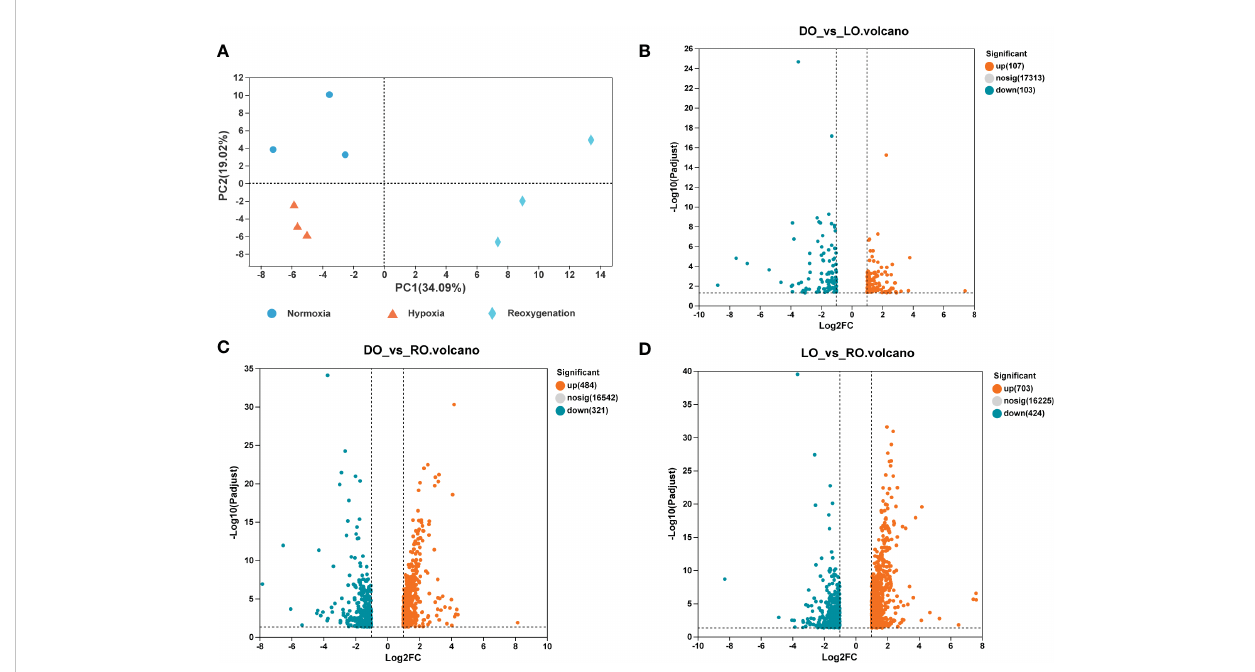
FIGURE 4 Clustering of liver samples and differentially expressed genes. (A) Two-dimensional principal component analysis (PCA) plots of liver transcriptome data (B) Map of DEGs volcanoes (normoxia vs hypoxia). (C) Map of DEGs volcanoes (normoxia vs reoxygenation). (D) Map of DEGs volcanoes (hypoxia vs